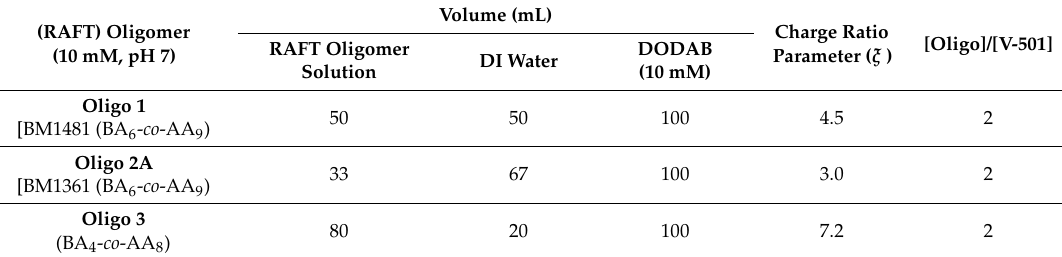
Table 2. Recipe for fortified vesicles for use in templated